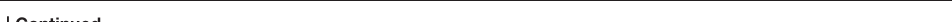
FIGURE 4 | Continued transformants and the wild-type strain on CM supplemented with 0.25 µ g/mL carbendazim and 0.40 µ g/mL dimetachlone, respectively, at different times. (K) Relative expression of sop1 in the wild-type strain in the various stress conditions tested as determined by qRT-PCR analysis. Samples were collected for gene expression detection at 3 dpi on CM without any treatment and CM with 0.02% SDS, 1M glucose, 1M sorbitol, 1.2M sucrose, 1M NaCl, 1M KCl, 0.25 µ g/mL carbendazim, and 0.40 µ g/mL dimetachlone, respectively. The abundance of cDNA from cultures on CM without any treatment was assigned a value of 1. The gene expression levels of sop1 were normalized to that of the β -tubulin transcripts from each sample. In all experiments at least three independent replications were performed, and the values are presented as the mean ± s.d. Bars indicate the standard error.